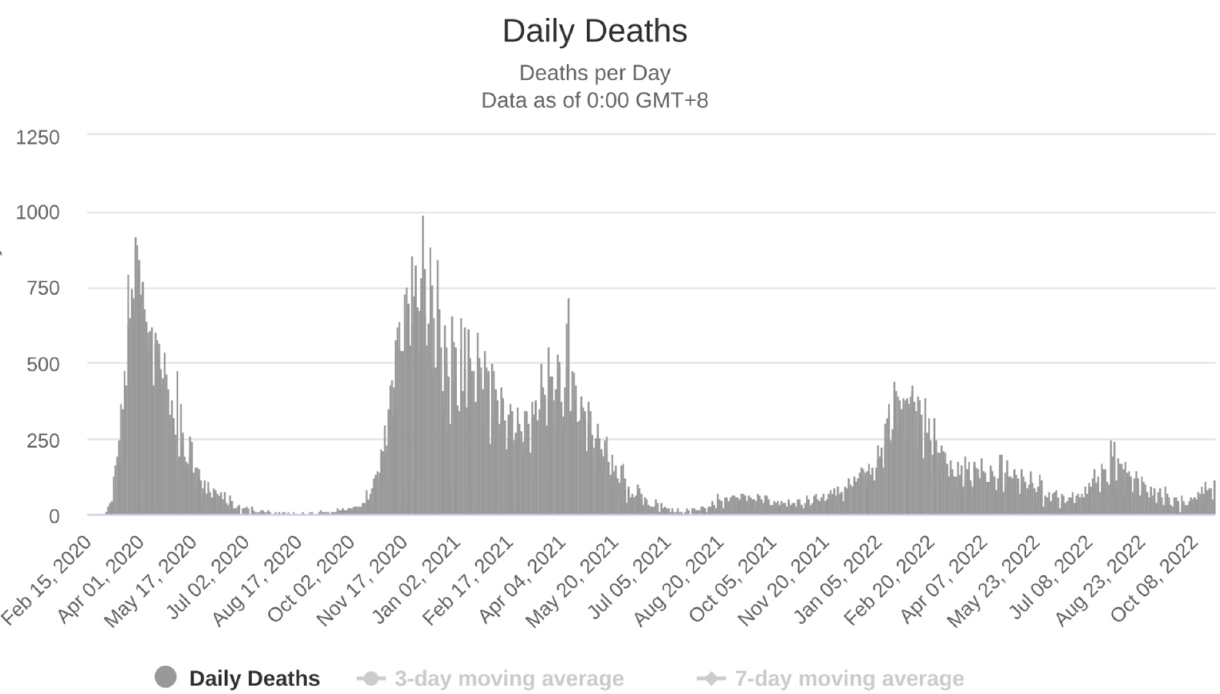
Figure 6. COVID-19 deaths in Hong Kong, China. Source: Worldometer (2022b) .